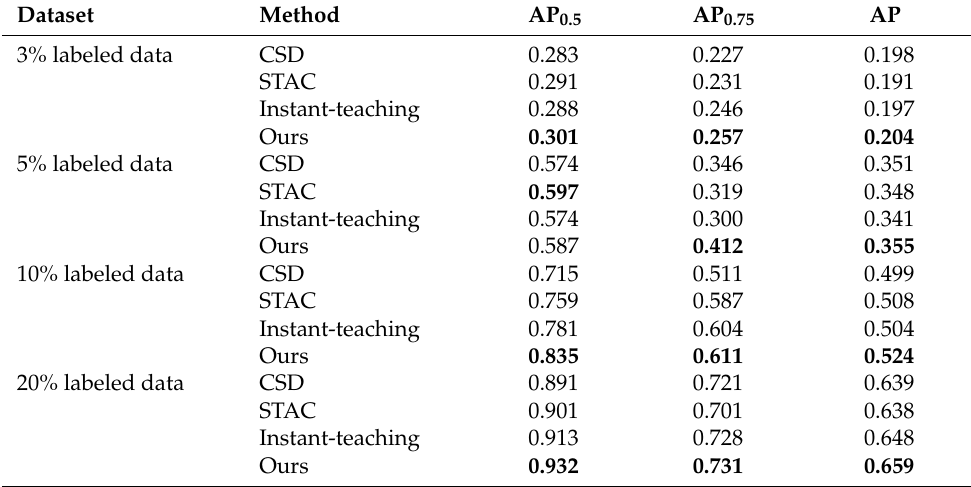
Table 8. Comparison with state-of-the-art semi-supervised methods.